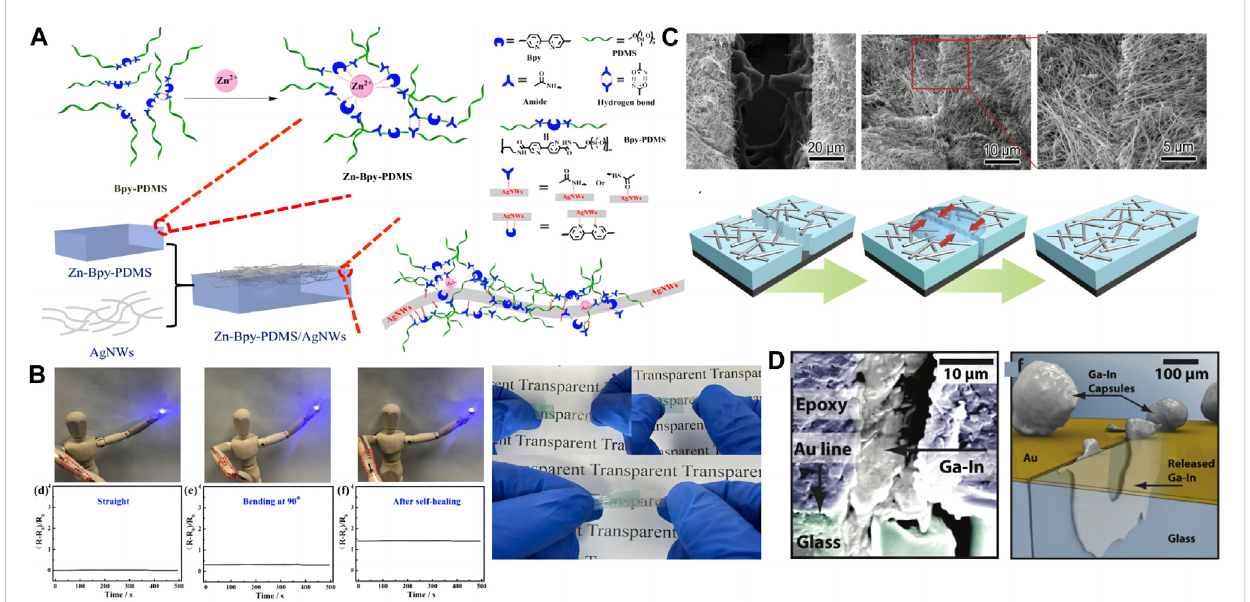
FIGURE 2 (A) Fabricationofthetransparentskin-like conductor. Schematic structureof theself-healingZn-Bpy-PDMS polymerand theinterfacial bonding of the Zn-Bpy-PDMS/AgNWs conductor (Ye et al., 2019). (B) Resistance change test of materials after self-repair Photos to demonstrate the self-healing capability of Zn-Bpy-PDMS: cut, self-healing (herein, 24 h at room temperature), and stretching after healing (offside) (Ye et al., 2019). (C)